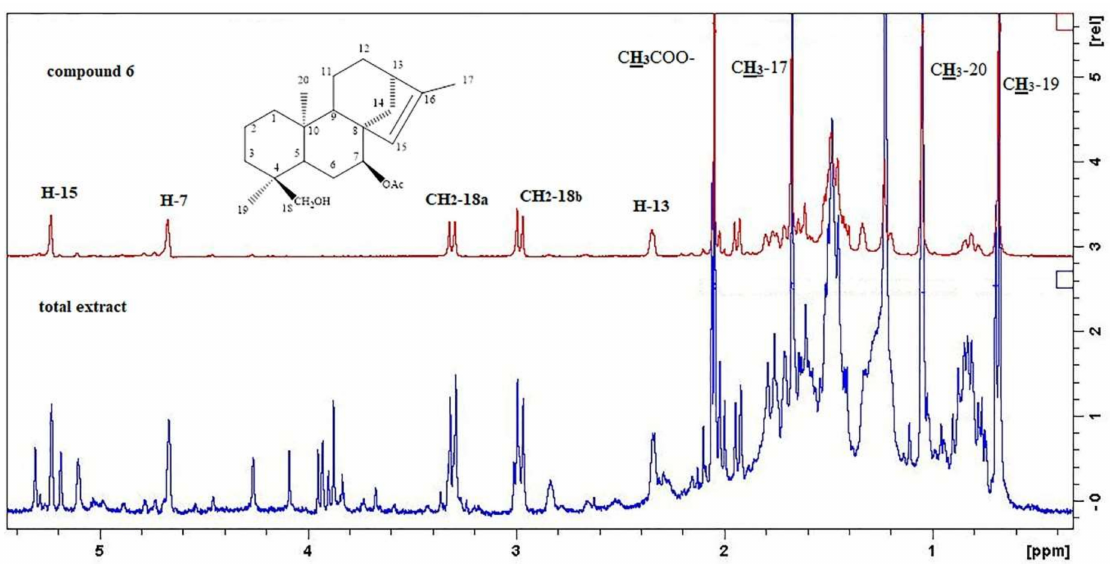
Figure 2. Structures of isolated compounds 1 – 11 .